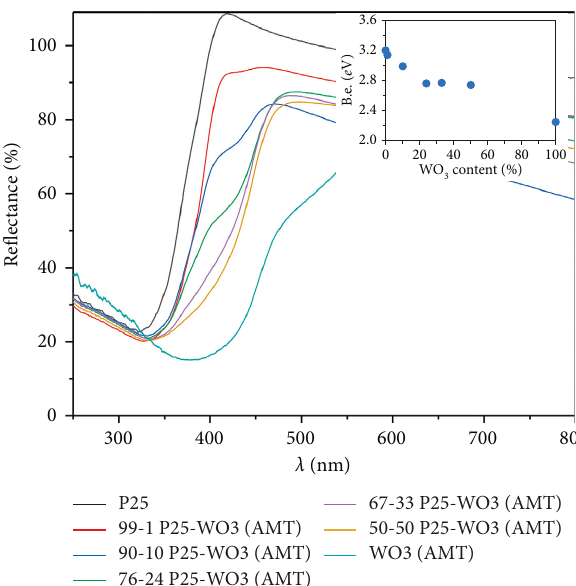
Figure 2: The reflectance spectra of the prepared WO composites system and the band-gap energy dependence on the 3 and commercial TiO 2 , WO 3 content (inset figure).